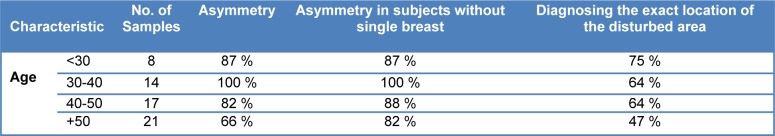
The sensitivity of the detection of abnormal are as using asymmetry techniques with respect to the age of patients in the thermal images